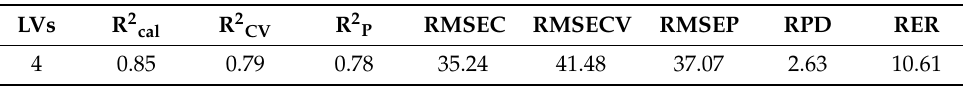
Table 3. Parameters and figures of merit of the PLS model for the determination of acrylamide through the use of E-nose.